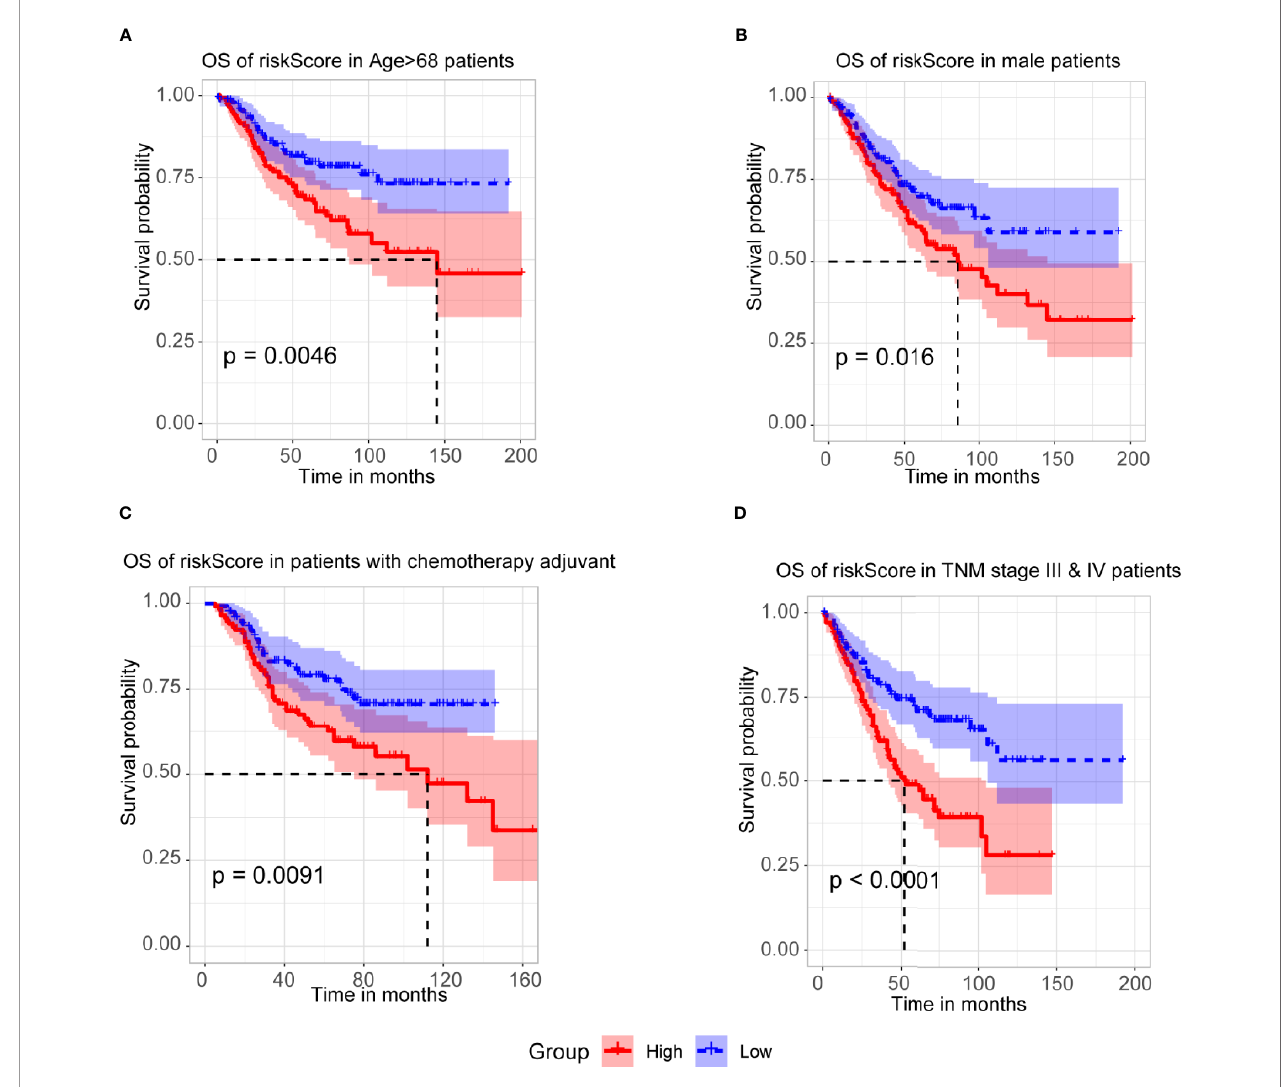
FIGURE 5 | Strati fi cation Analysis of the m6A-TME-LM. (A) CC patients with higher risk score of m6A-TME-LM had worse survival rate in age > 68 subgroups. (B) CC patients with higher risk score of m6A-TME-LM had worse survival rate in male subgroups. (C) CC patients with higher risk score of m6A-TME-LM had worse survival rate in chemotherapy adjuvant subgroups. (D) CC patients with higher risk score of m6A-TME-LM had worse survival rate in TNM stage III and IV